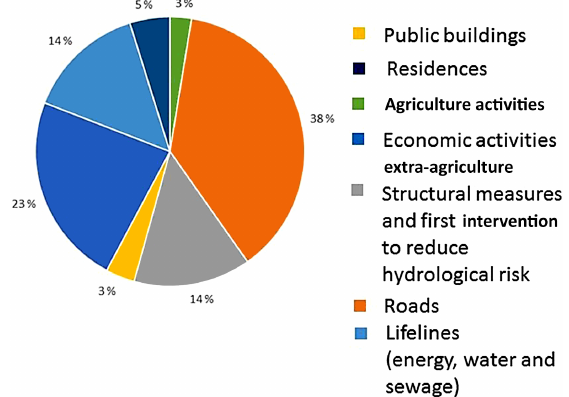
Figure 2. Distribution of damage among the different exposed sec- tors for the November 2012 flood in